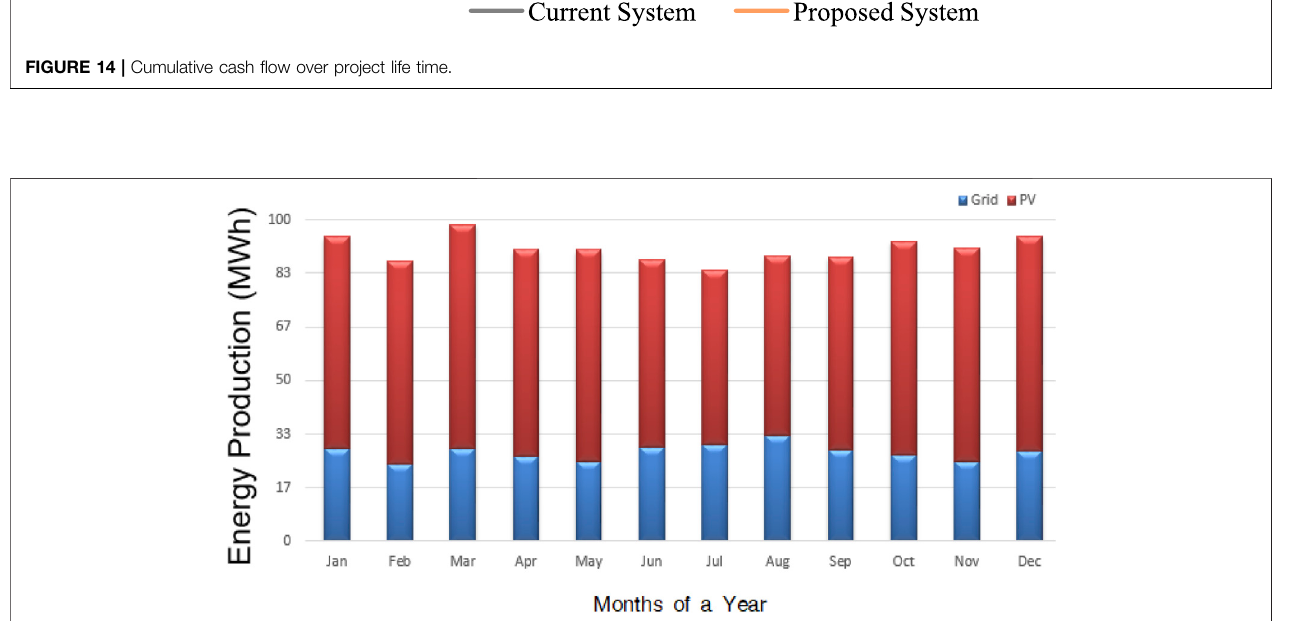
FIGURE 15 | Total energy production from two sources.